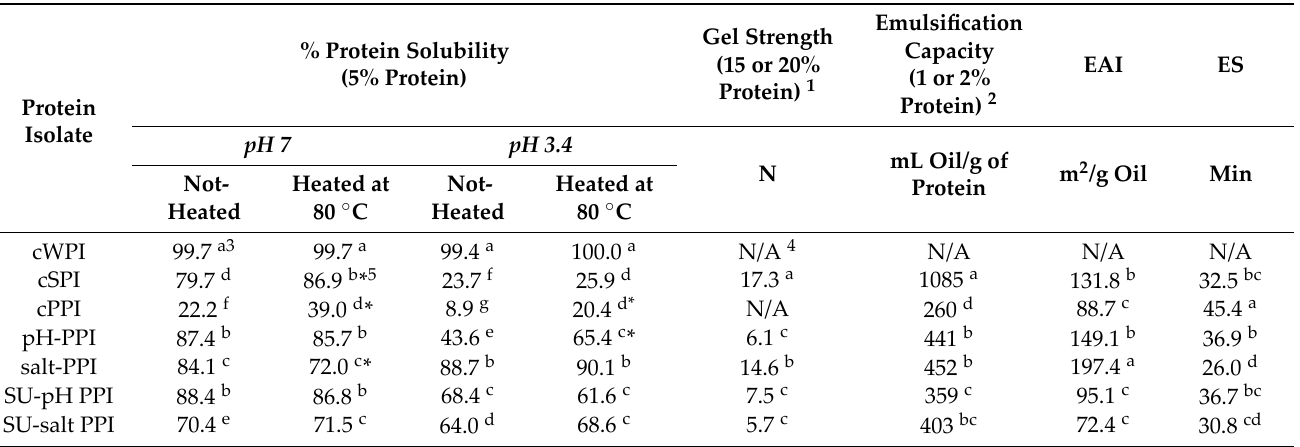
Table 4. Solubility, gel strength and emulsification properties of commercial protein references and PPI samples produced at bench scale and pilot